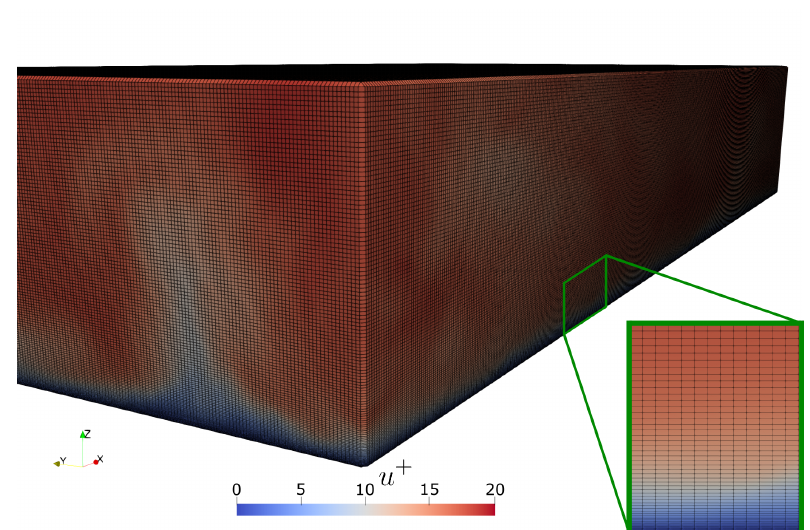
Figure 2. Visualization of the Eulerian grid adopted in our simulations over half of the channel height. Grid points are located at the intersection between black lines. The grid spacing in the streamwise x and spanwise y coordinates is uniform, and is simply determined by the chosen number of points ( dx = L x / n x = dy = L y / n y ). Chebyshev polynomials, given by the following